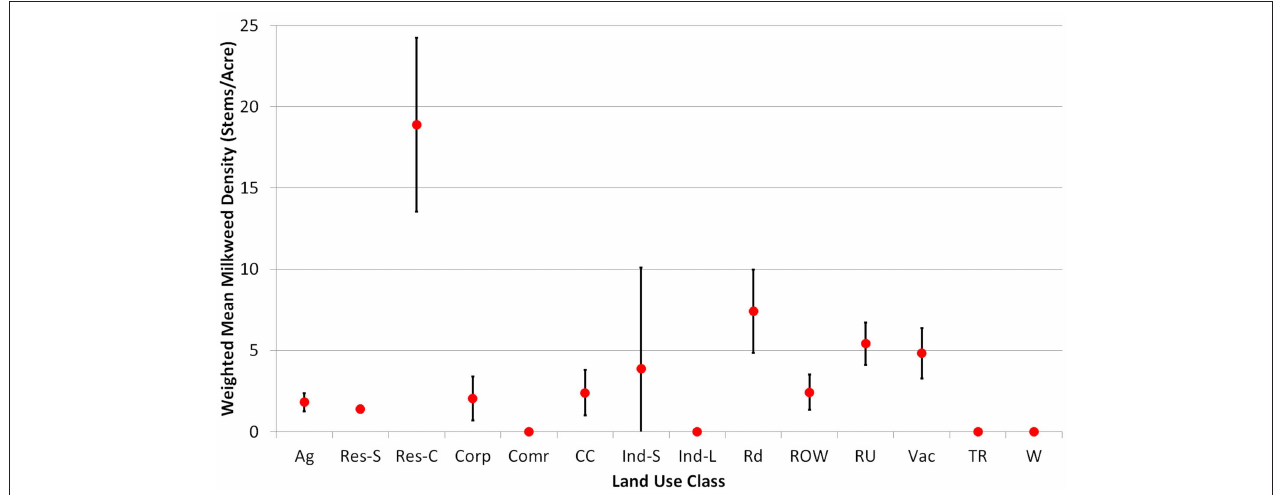
FIGURE 7 | Chicago baseline weighted mean milkweed densities (calculated on a grass/shrub and 20% tree basis) for the metro-transect sampling results. Standard error around the mean are indicated by lines. Metro-transect sampling was used for all land use classes except for open space which used density values provided by Thogmartin et al. (2017b).